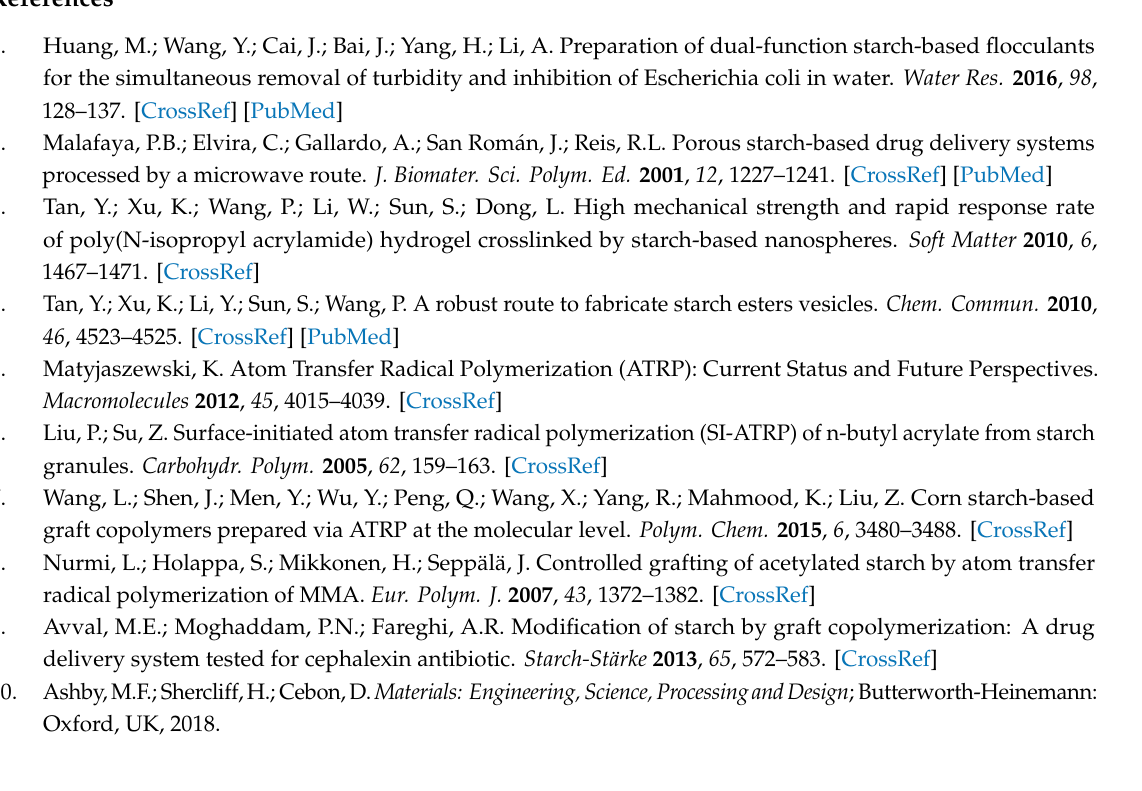
Figure S1: Particle size distribution (PSD) of Pioneer clay and Calcined clay by intensity. Figure S2: TGA curves of starch, starch-Br, St-g-PDMC, St-g-PAMPS, and